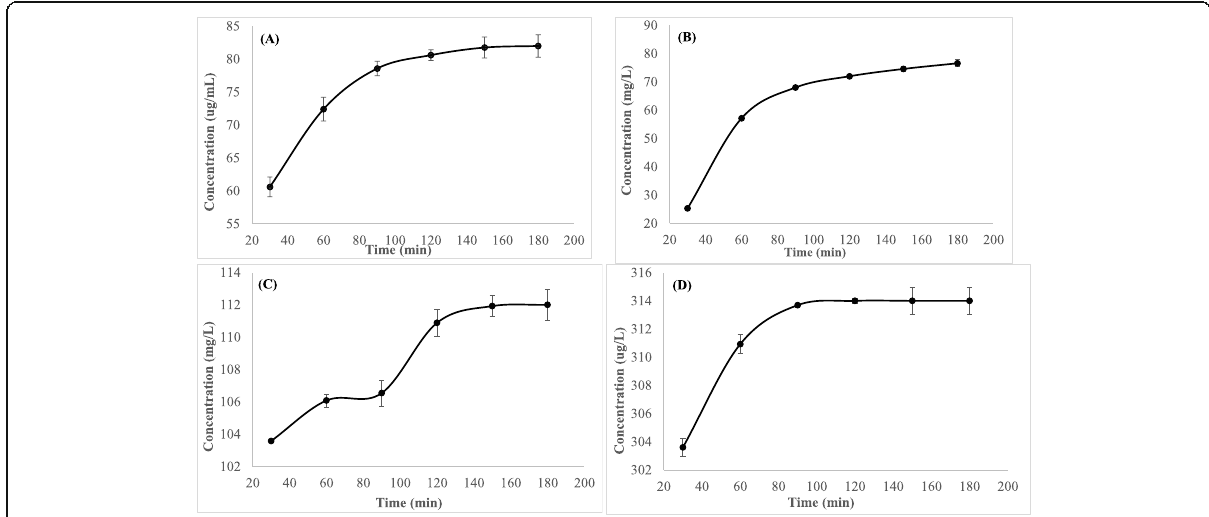
Fig. 4 Release concentration of alpha-cypermethrin ( A ), deltamethrin ( B ), lambda-cyhalothrin ( C ), and permethrin ( D ) after time intervals for 3 h and standard error (n =